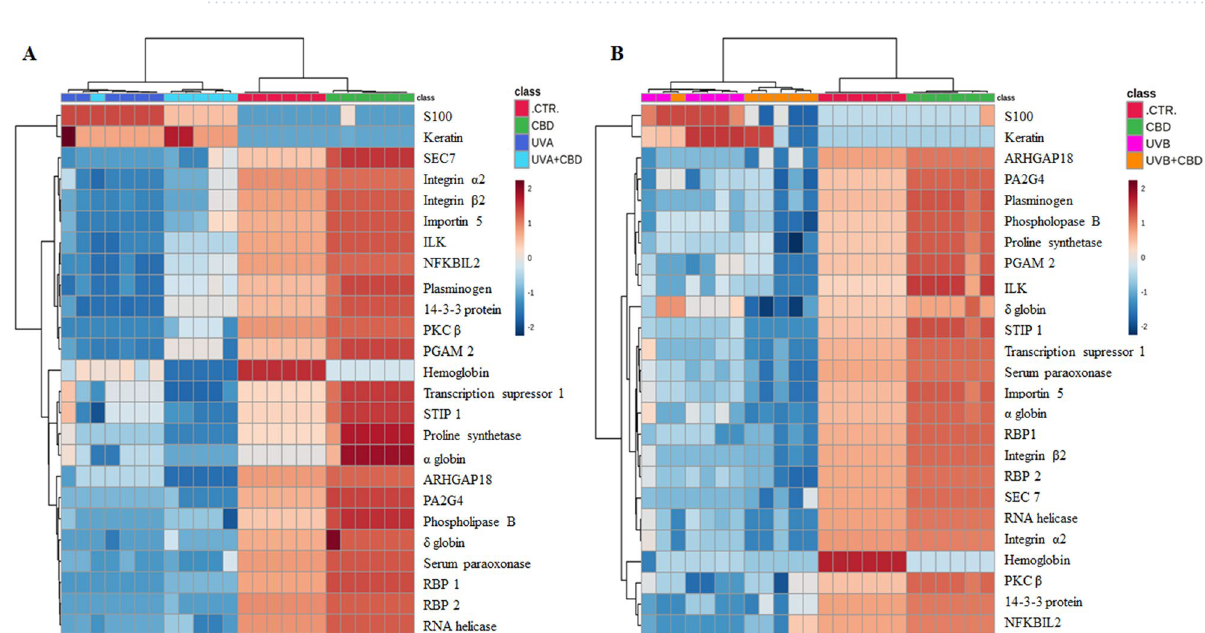
Figure 3. Dendrograms and heatmap for 25 top-modified ANOVA-selected proteins from plasma of control rats (CTR) and animals topically treated with cannabidiol (2.5 g CBD in 100 g petrolatum) and/or irradiated with UVA (increasing doses from 0.5 to 5 J/cm 2 ) ( A ) or UVB (increasing doses from 0.02 to 2 J/cm 2 ) ( B ). Statistical analysis were performed using open-source software MetaboAnalyst 5.0 (www. metab oanal yst. ca). Abbreviations, ARHGAP18, Rho GTPase activating protein 18; ILK, integrin-linked kinase; NFKBIL2, NFκB inhibitor; PA2G4, proliferation-associated 2G4; PGAM 2, phosphoglycerate mutase 2; PKC, protein kinase C; RBP, RNA-binding protein; SEC 7, transport protein 7; STIP 1, septin and tuftelin interacting